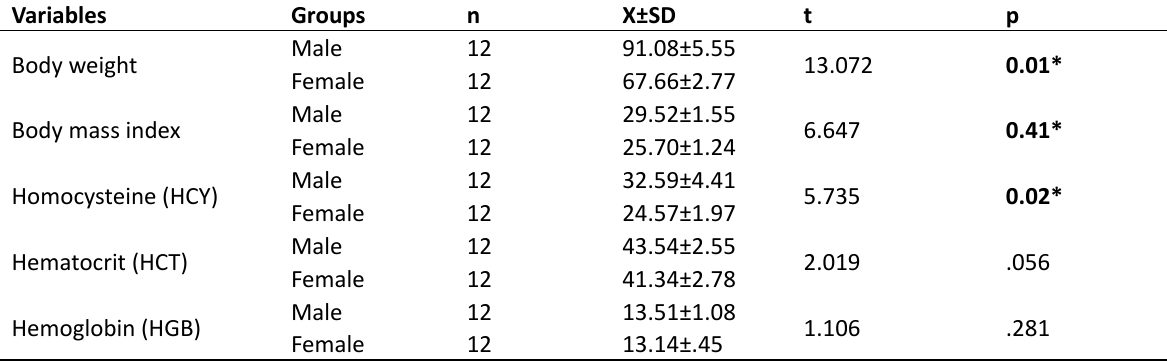
Table 2. Comparison of the inter-group pretest values Variables